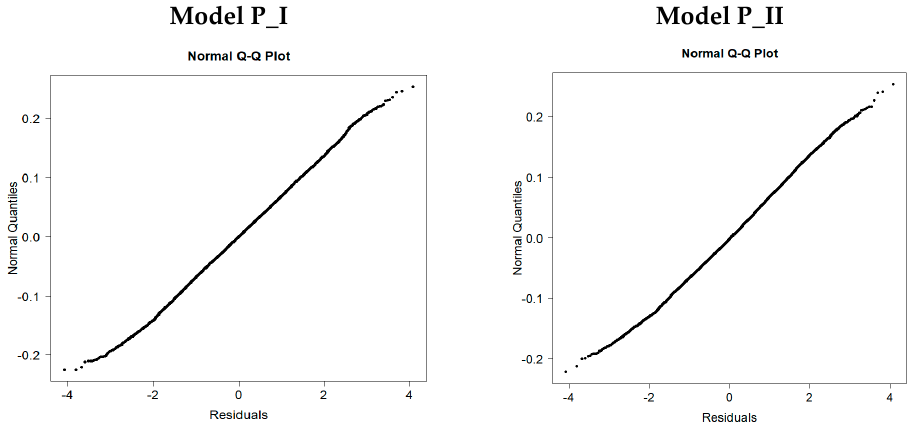
Figure 6. Normal quantile–quantile (Q-Q) plot of the standardized residuals from Models P_I and II.